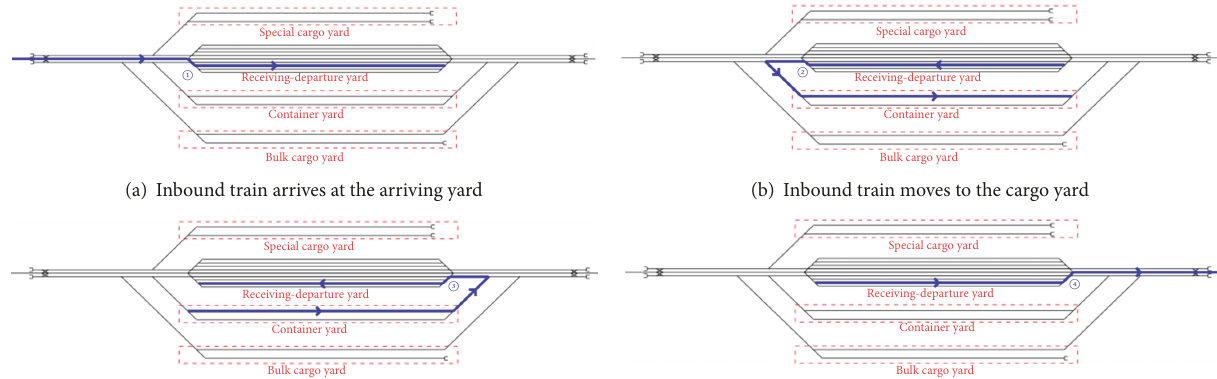
Figure 2: Trajectories of train